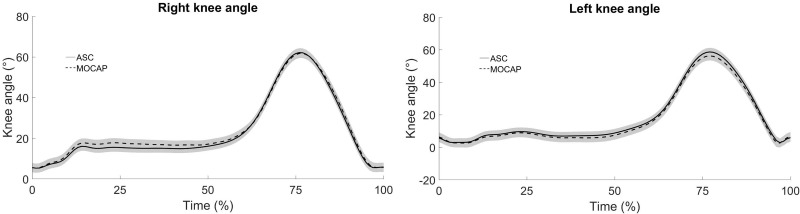
Mean curve of the angular variation, of the right and left knee, of 17 stride cycles in one walking trial (40 meters).Vicon (dashed line) and GoPro (continuous line).